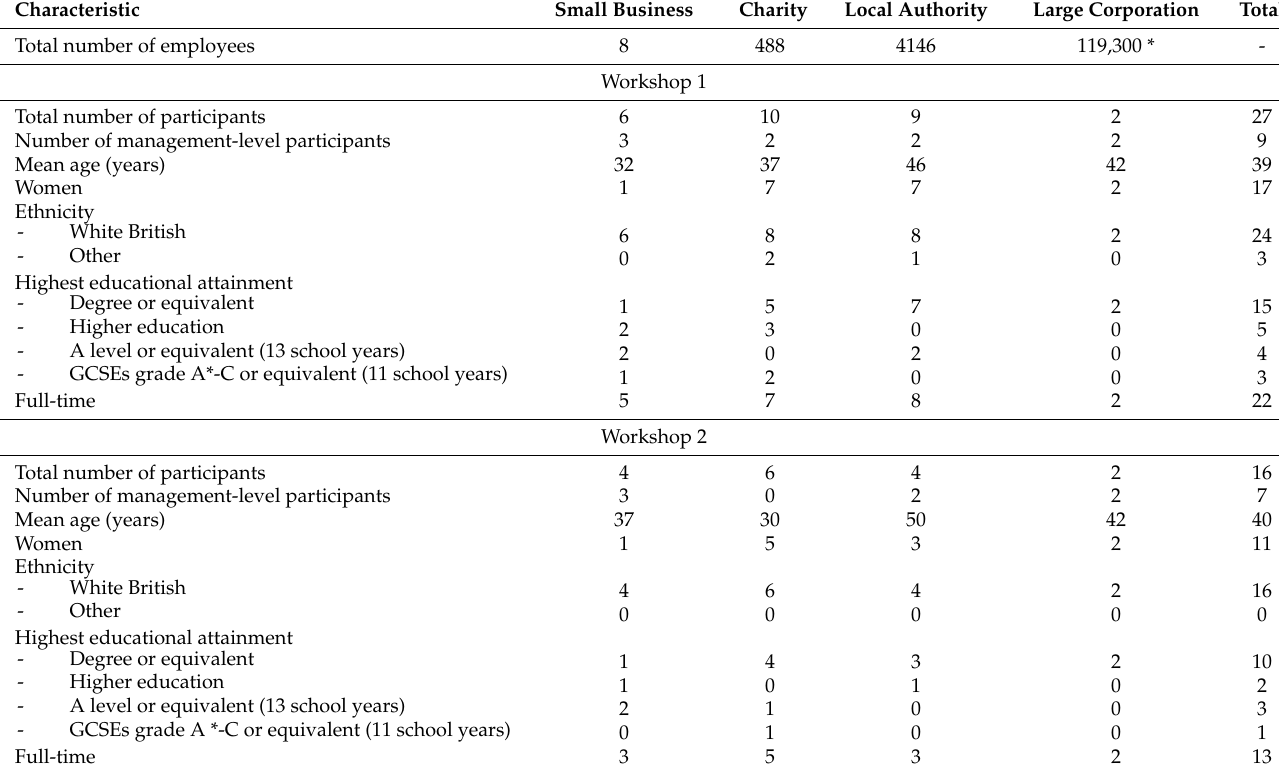
Table 1. Participant characteristics for workshops 1 and